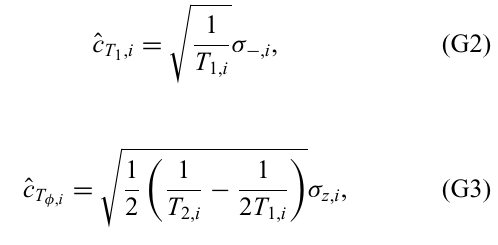
TABLE IV. (First four rows) Percentage of data kept after discarding all measured states containing at least one leakage event. (Bottom four rows) Corresponding average leakage per two-qubit gate in percent. No. of layers,